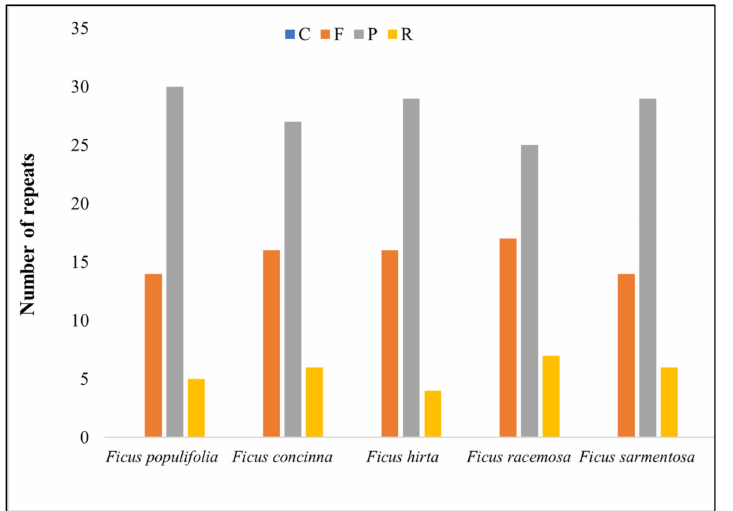
Figure 7. Number of different repeats in the five plastomes of Ficus . P = palindromic, F = forward, R = reverse, and C =